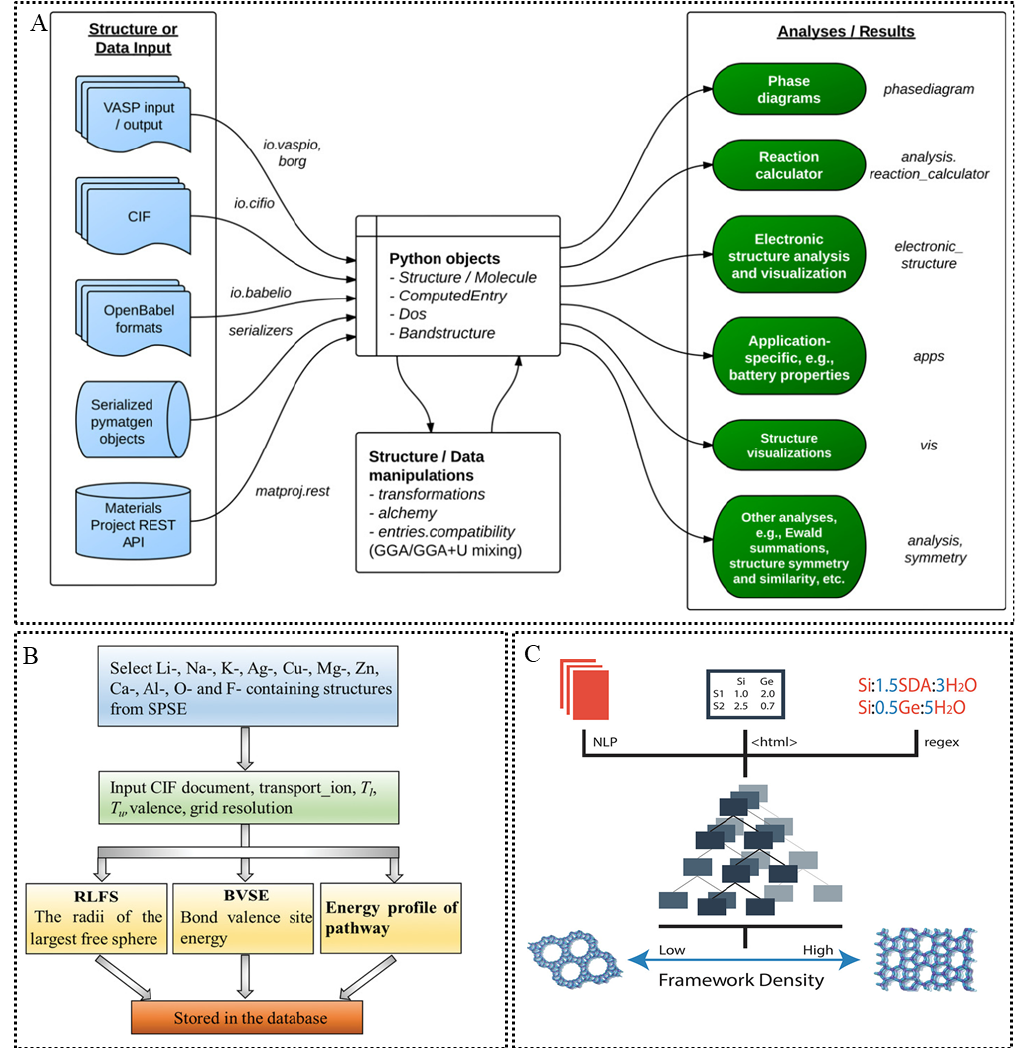
Figure 2. ( A ) Overview of the pymatgen library. Text in italics represents names of Python packages, modules, or classes. Reprinted from Reference [26] with permission from Elsevier. ( B ) The architec- ture of the ionic transport characteristics database. Reprinted from Reference [29] with permission from John Wiley and Sons. ( C ) Schematic overview of zeolite data engineering, including (1) litera- ture extraction from sources such as NLP from body text, parsing of HTML tables and regex match- ing between text and tables, (2) regression modeling and (3) zeolite structure prediction. Reprinted from Reference [37] with permission from American Chemical Society. 3. Descriptor ML models expect the input data to be in the form of letters or numbers. However, the large amount of feature data about the materials we obtain in the original dataset is unsuitable for ML. Therefore, we need to encode and convert material structure data into descriptors (also called feature vectors in ML terminology) that computers can understand through feature engineering. Mapping structure and composition into descriptors that can be easily transported to the ML process is crucial in predicting materials [38]. The input descriptors are more appropriately, the better the ML algorithm can map to the final out- put data [39]. Depending on the problem under study and the prediction accuracy re- quired, descriptors can be defined as: the higher expected precision needs data-intensive